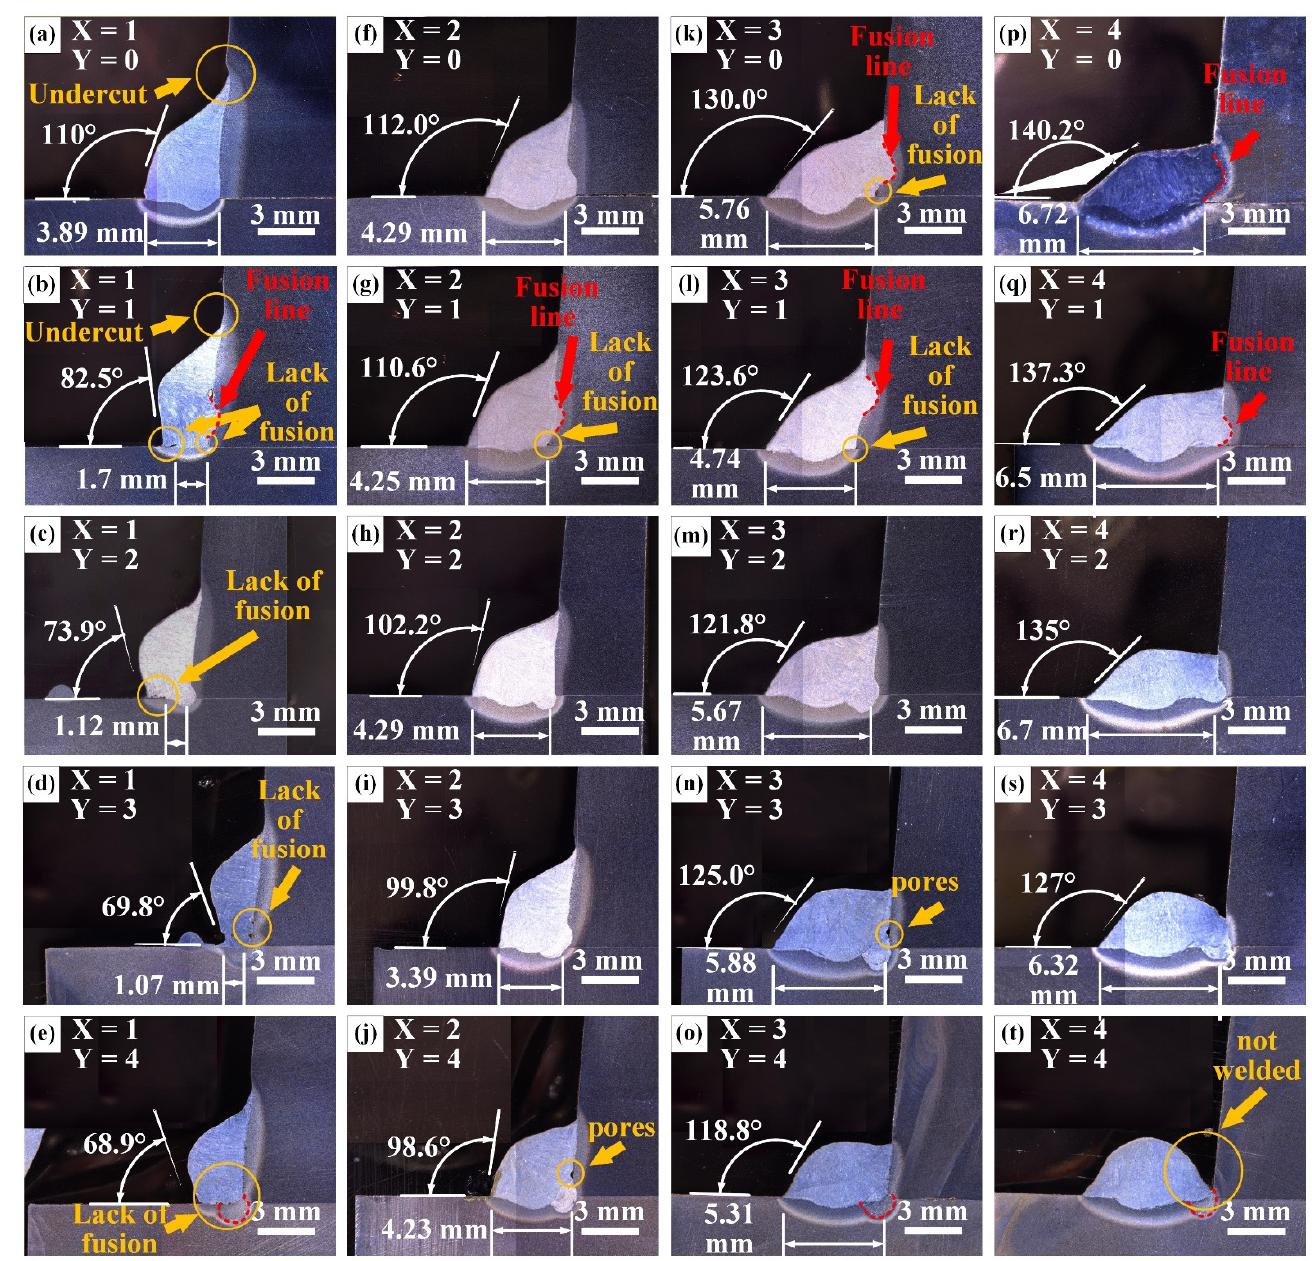
Figure 5. Macroscopic morphology of the weld with different misaligned laser–arc distances (W =